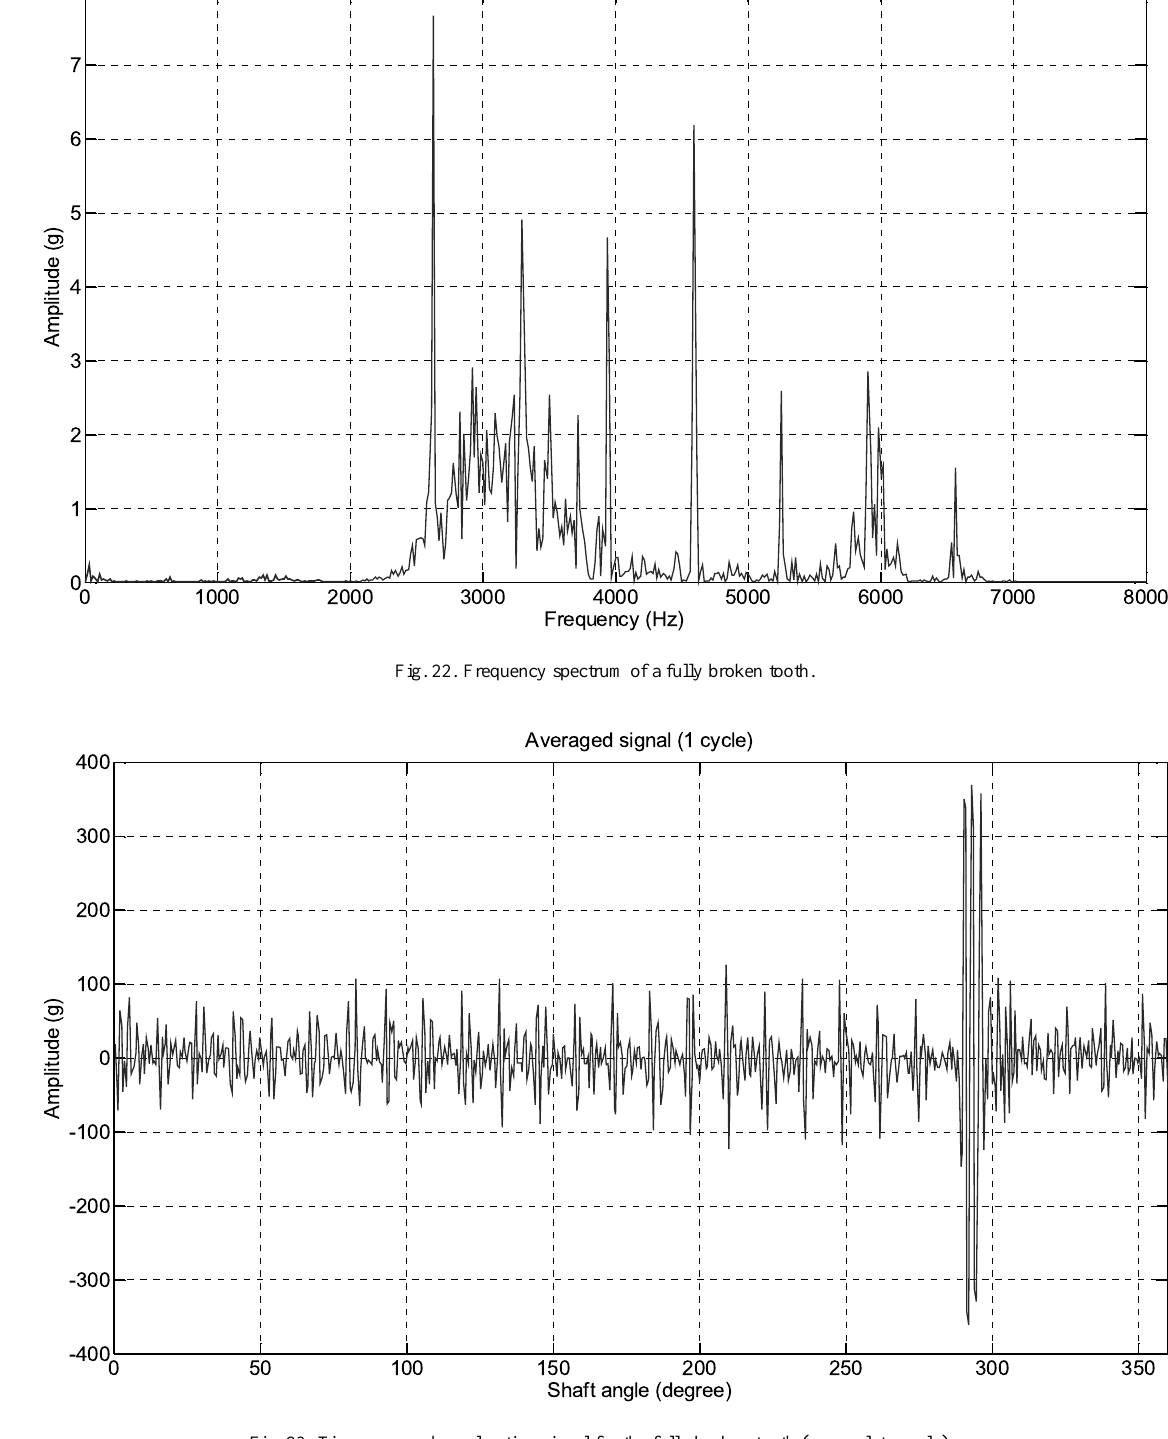
Fig. 23. Time averaged acceleration signal for the fully broken tooth (a complete